Question: What type of chart is this?
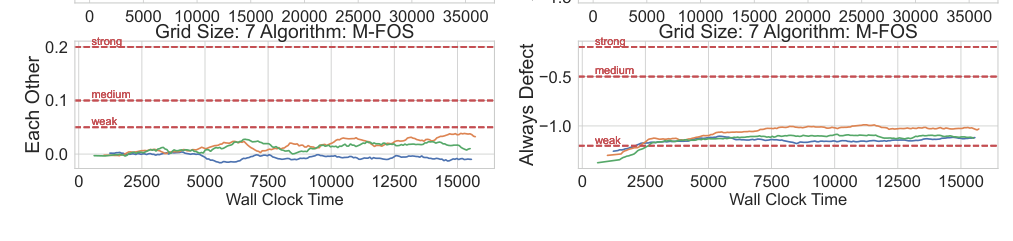
Answer: line